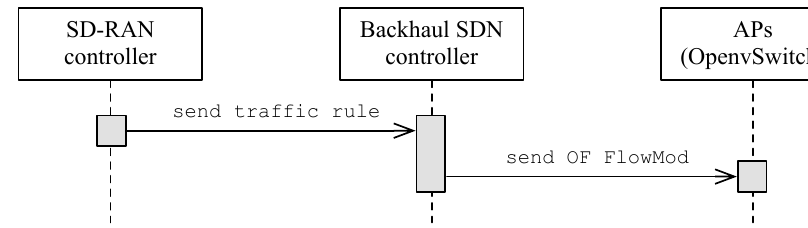
Figure 2. Sequence diagram of the traffic rule creation process.